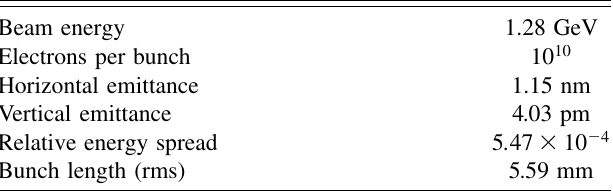
TABLE I. Nominal beam parameters for the ATF prototype damping ring [12]. Beam energy